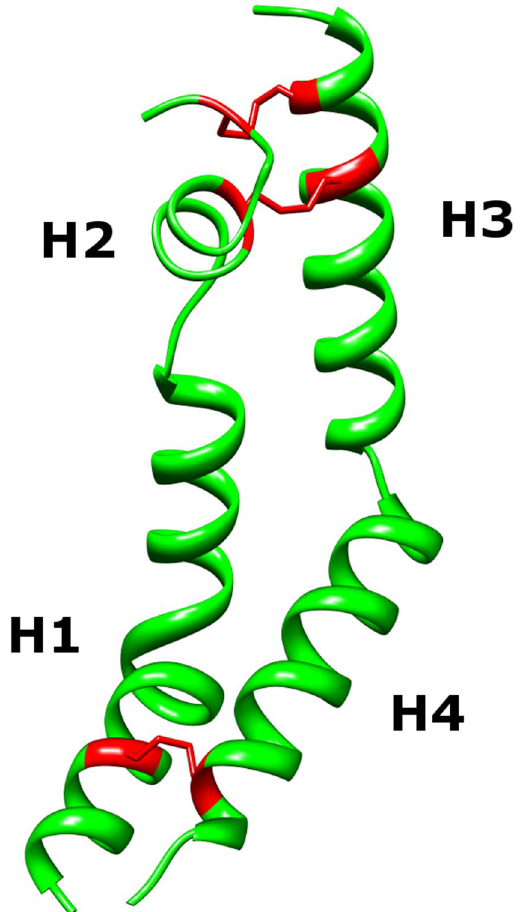
Figure 1. Crystal structure of StAP PSI (3RFI). The StAP PSI crystal structure was divided into structural regions based on helix content, identified as H1, H2, H3, and H4. The sequence bridging H2 and H3 was not resolved in 3RFI and is denoted as peptide “X”. The peptide sequences, and aromatic and ionisable residues are detailed in the Methods section under the heading PSI Structure Component Peptides. The positions of the three disulfide bonds (bottom to top; C6-C99, C31-C71, and C37-C68) are shown in